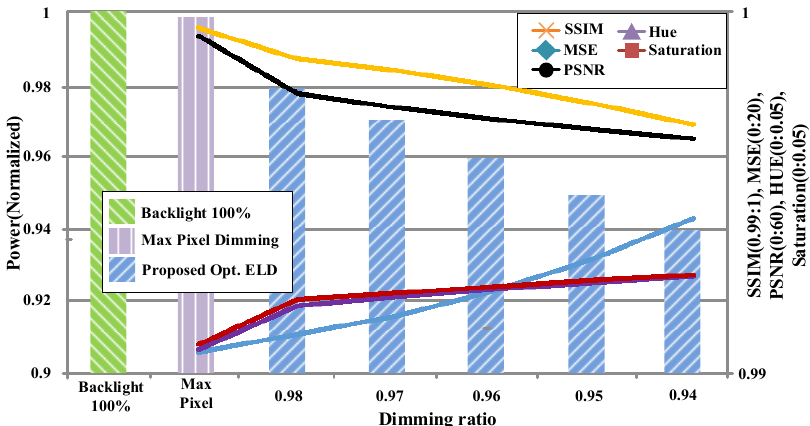
Figure 10. Image quality and power consumption with respect to dimming ratio.